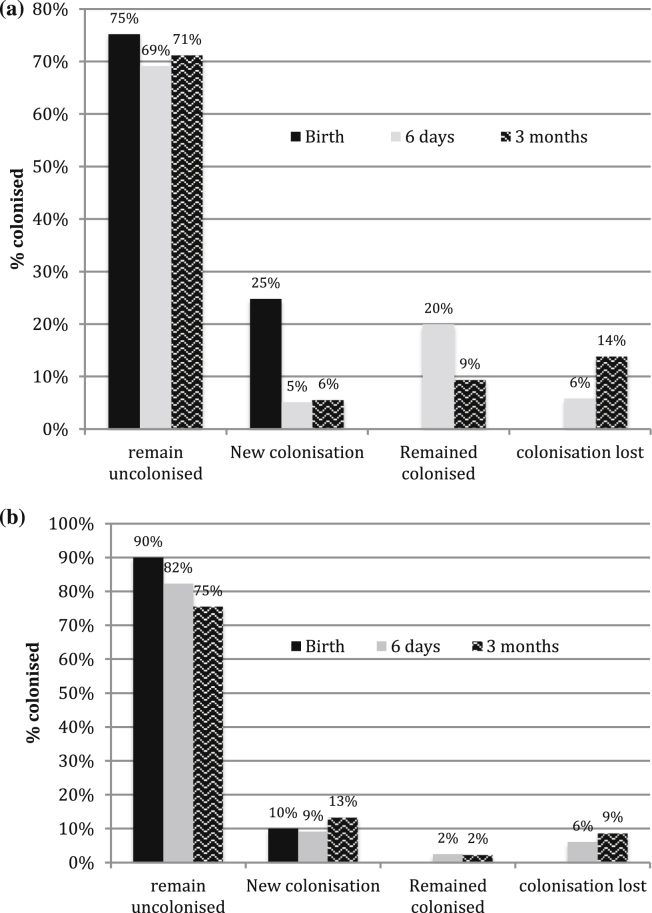
a – infant GBS colonisation status over time. Bars represent percentage of infants colonised at each of the time points; black bar = birth, grey = day 6 and patterned = three months. b – breastmilk colonisation over time. Bars represent percentage of infants colonised at each of the time points; black bar = birth, grey = day 6 and patterned = three months.